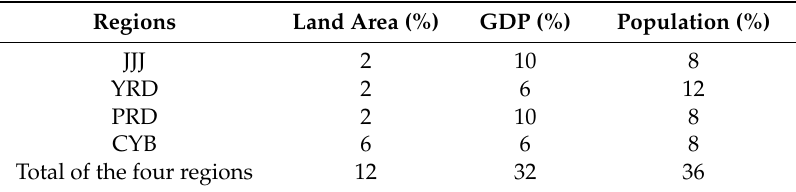
Table 1. The proportion of several parameters in key